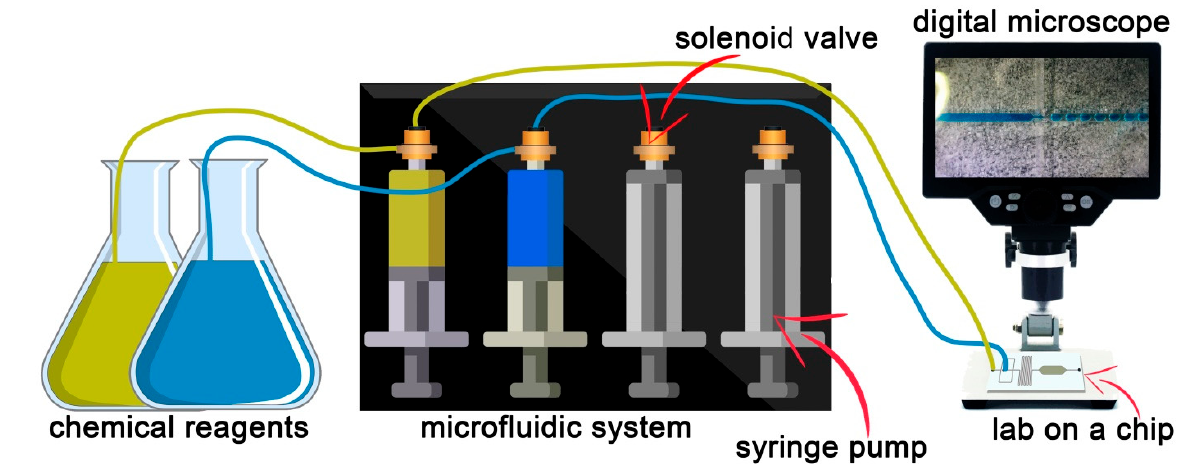
Figure 2. The instrumental check common scheme based on the chemical synthesis results.